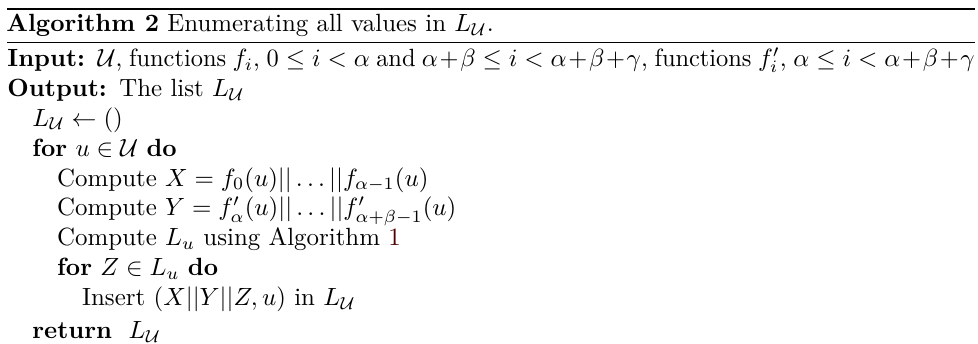
Algorithm 2 Enumerating all values in L U